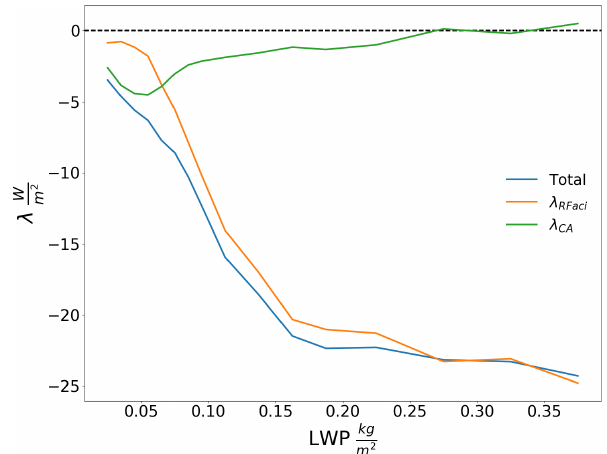
Figure 2. The RFaci warm , cloud adjustment, and sum of the two susceptibilities, decomposition susceptibility, found within regimes of cloud state defined by LWP. The total decomposition susceptibil- ity is − 7 . 04Wm − 2 ln(AI) − 1 .